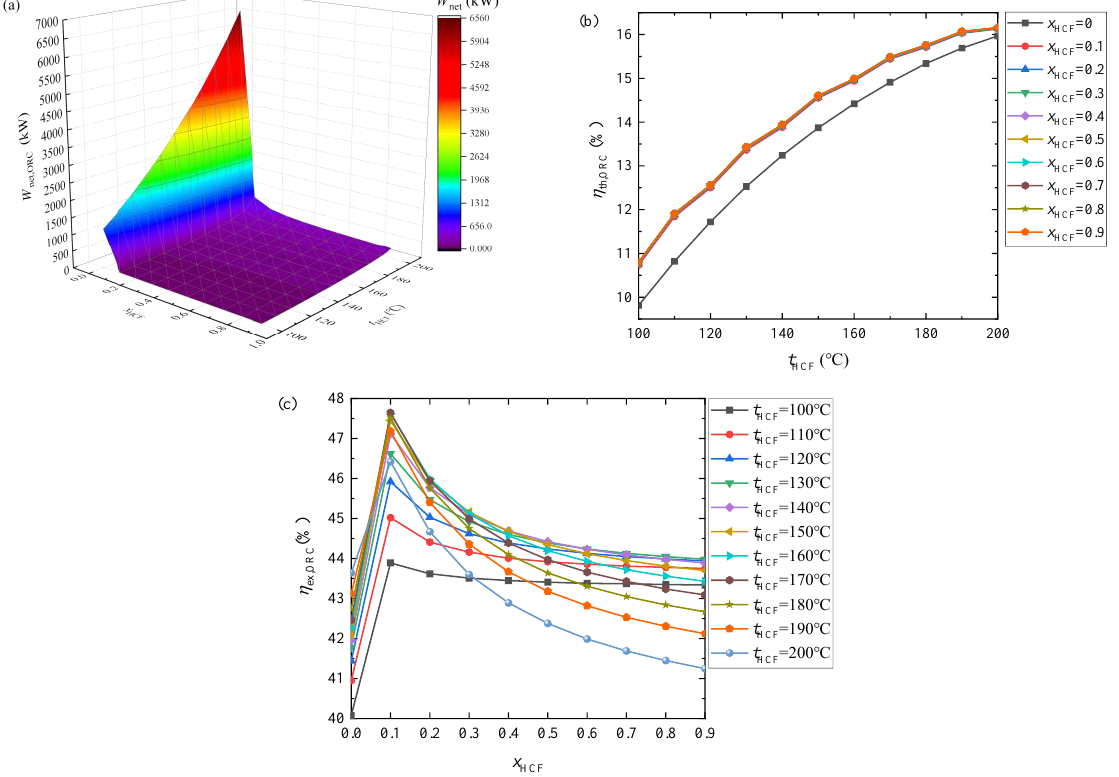
Figure 17. Variation of optimal thermodynamic parameters of the ORC system with steam quality at different heat carrier temperatures: ( a ) W net, ORC , ( b ) η th, ORC and ( c ) η ex, ORC. The variation curves of the optimal thermodynamic parameters of the SFORC for dif- ferent heat-carrying fluid temperatures and different steam quality are shown in Figure